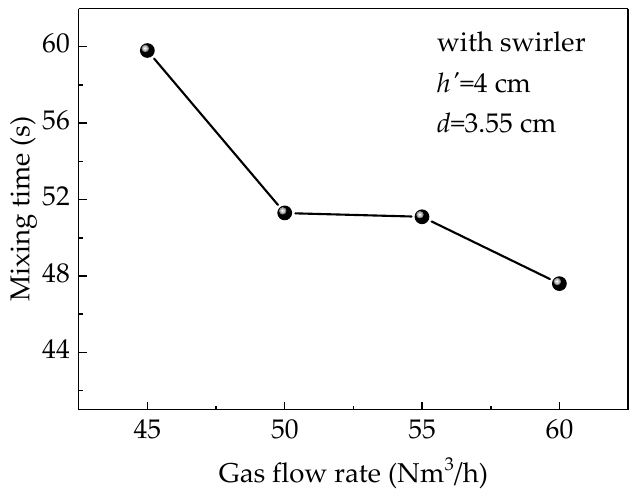
Figure 10. Simulated results of the effect of different gas flow rates on the mixing time.